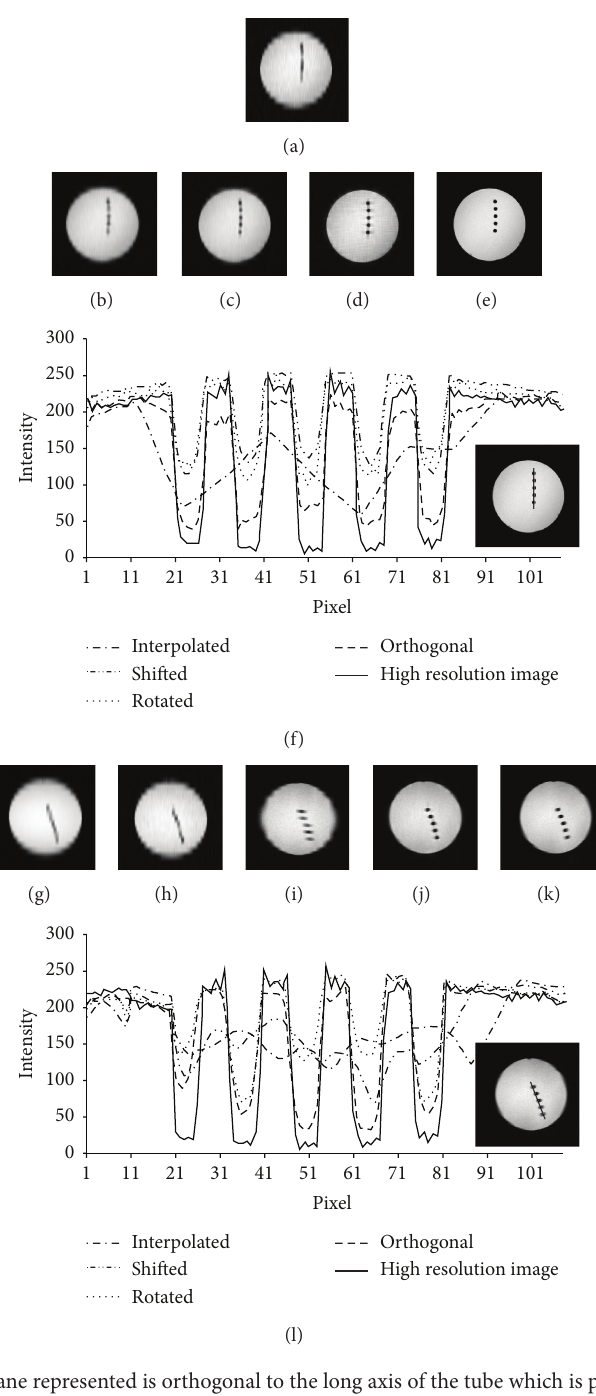
Figure 6: 2D slice images (image plane represented is orthogonal to the long axis of the tube which is placed along 𝑌 -axis in Figure 2(a)) of resolution phantom where the long axis of the tubes is orthogonal to the acquisition plane and LR image stacks were collected with a voxel AR of 1:1:10: (a) interpolated, (b) shifted, (c) rotational, (d) orthogonal, (e) inplane, and (f) line plot, and where the long axis of the tubes is oblique to the acquisition plane: (g) interpolated, (h) shifted, (i) rotational, (j) orthogonal, (k) inplane, and (l) line plot.